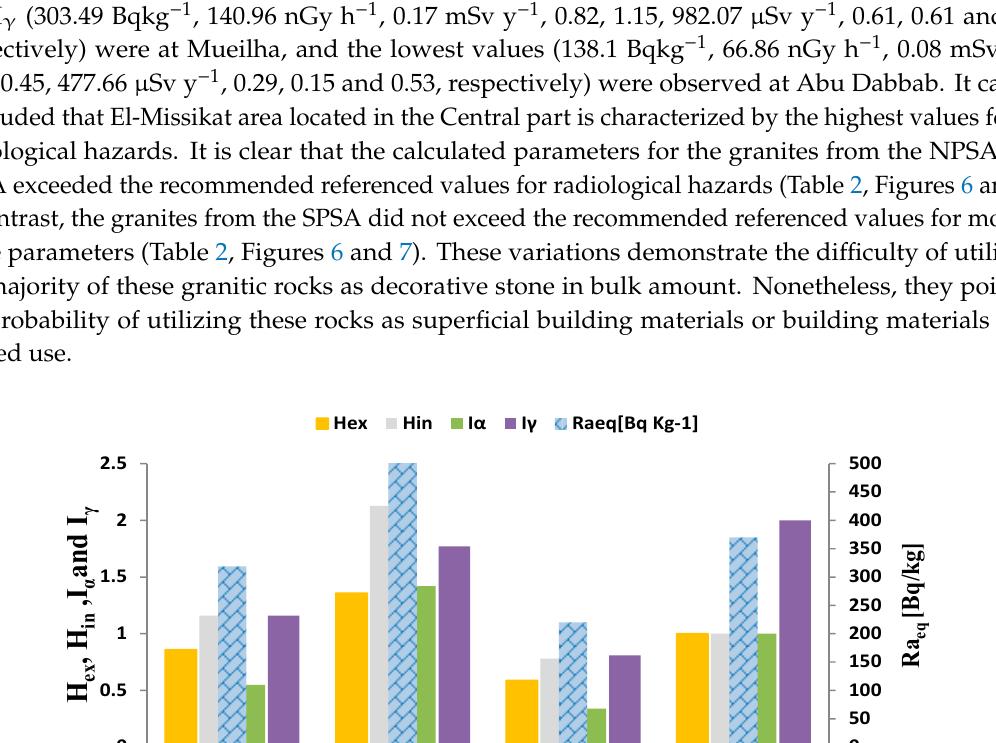
Figure 5. Similarity among the locations of the three parts depending on the radionuclide concentrations in term of cluster analysis.